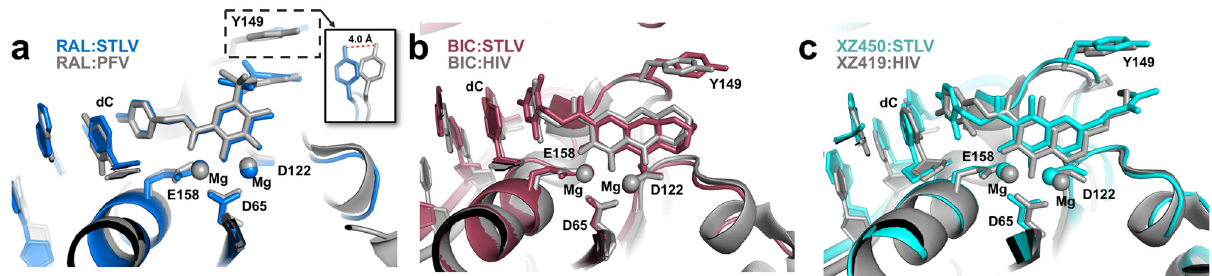
Fig. 5 Similarities to other retroviral intasome:INSTI complexes. Comparison between the mode of binding of RAL ( a ), BIC ( b ) and naphthyridine-based INSTIs XZ450 and XZ419 ( c ) to STLV-1 and HIV-1/PFV intasomes. The inset in a shows a signi fi cant shift in the position of STLV-1 residue Y149 (not visible in the original panel). PFV and STLV-1 IN have 35.8% sequence similarity, RMSD calculations comparing active sites were calculated as described in the Methods. For PFV intasome:RAL versus STLV-1 intasome:RAL the RMSD within the active site is 1.680 Å (214 atoms to 214 atoms). b HIV-1 and STLV-1 display 40.43% sequence similarity, RMSD within the active site between the HIV-1 intasome:BIC and STLV-1 intasome:BIC structures is 4.516 Å (238 atoms to 238 atoms). c RMSD within the active site for HIV-1 intasome:XZ419 versus STLV-1 intasome:XZ450 is 2.122 Å (228 atoms to 228 atoms). The following PDB models were used: 3OYA ( a ), 6PUW ( b ) and 6V3K ( c ). Superpositions were conducted by the align function in PyMOL and